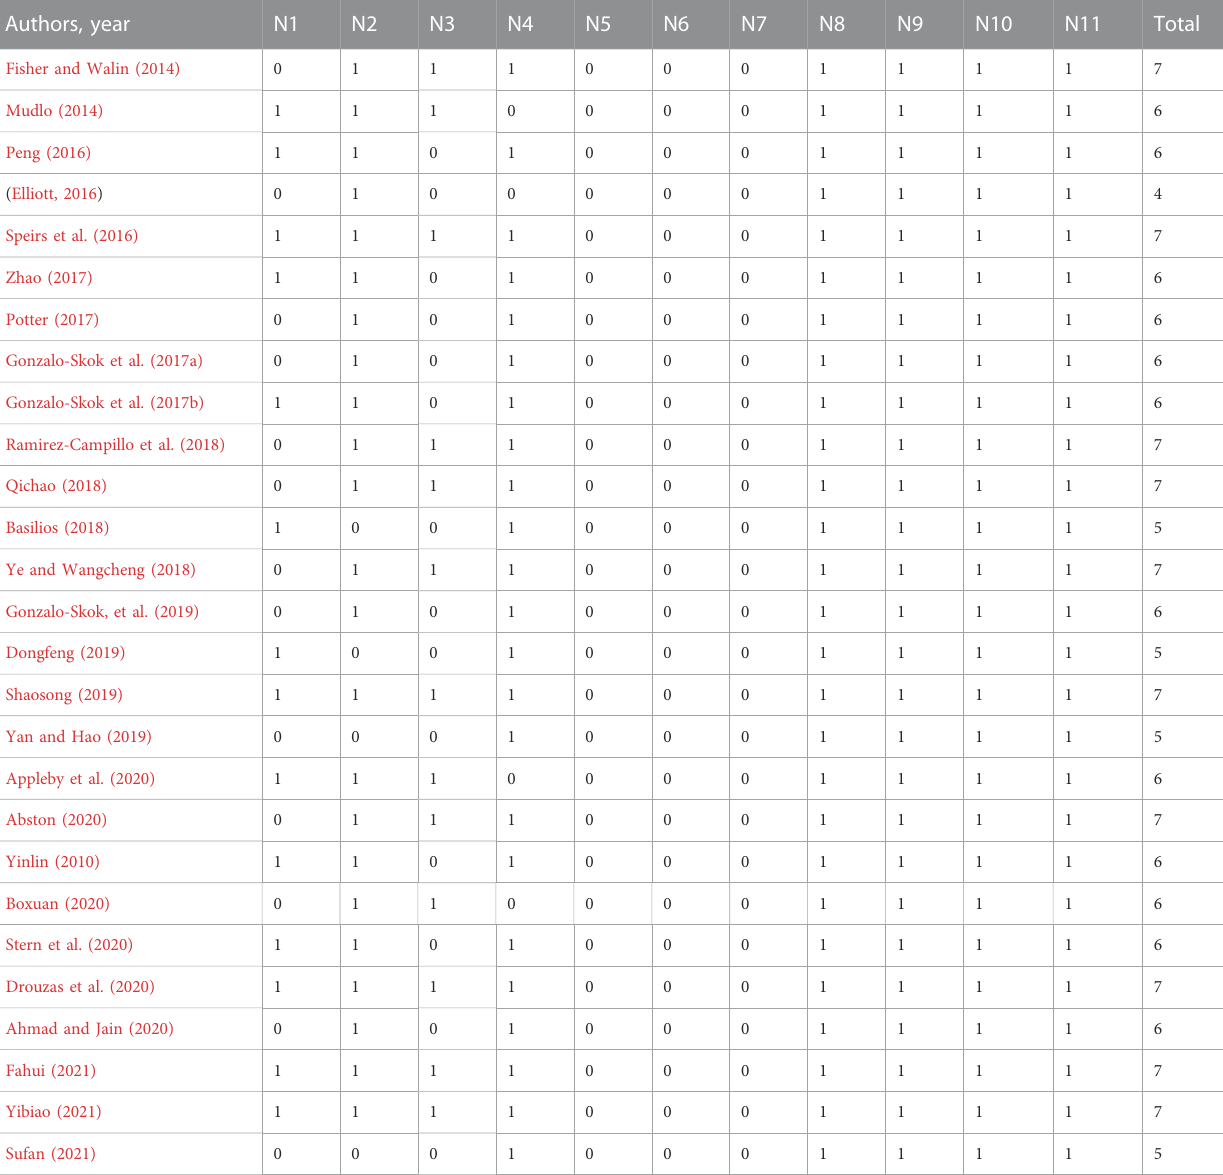
TABLE 3 The Physiotherapy Evidence Database (PEDro) scale